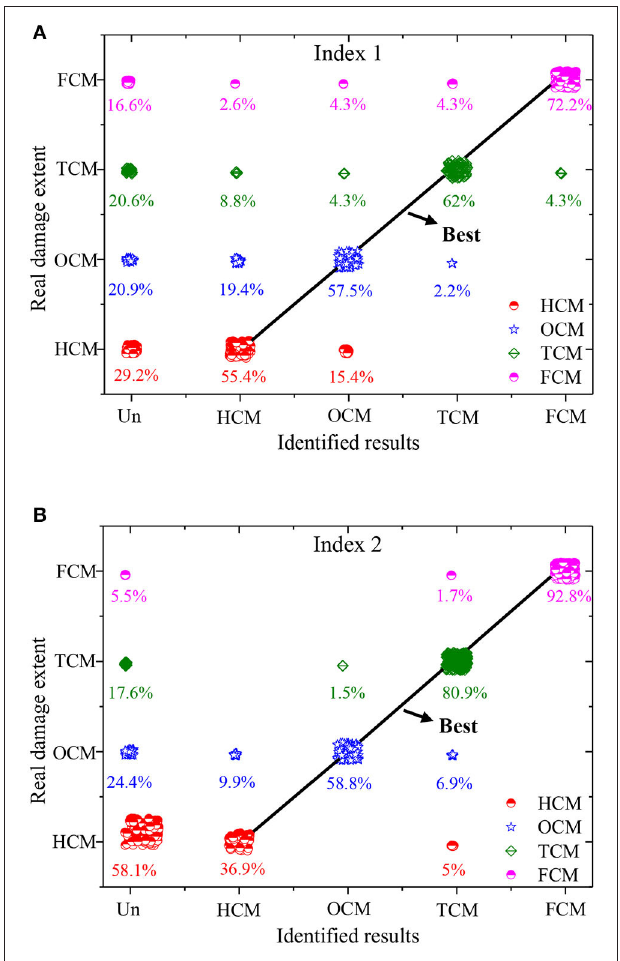
FIGURE 9 | The statistical results. (A) DI-1 and (B) DI-2. HCM, half-cell missing; OCM, one cell missing; TCM, two cells missing; FCM, four cells missing.